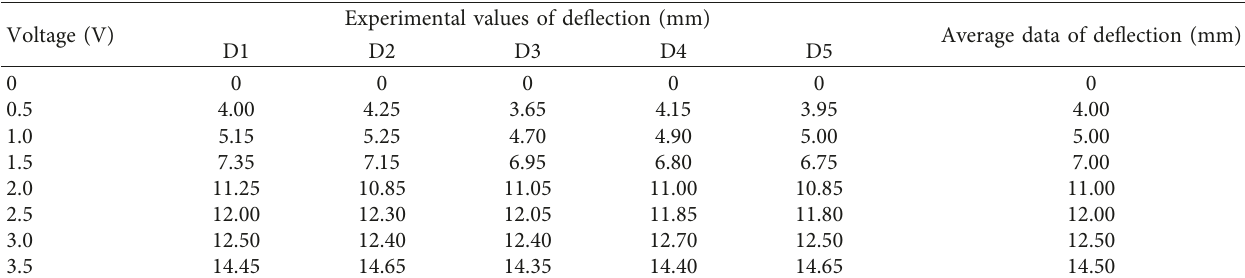
Table 3: Experimental deflection data of the PANI/PVC-PEDOT: PSS-ZrP membrane with applied voltages. Experimental values of deflection Voltage (V)